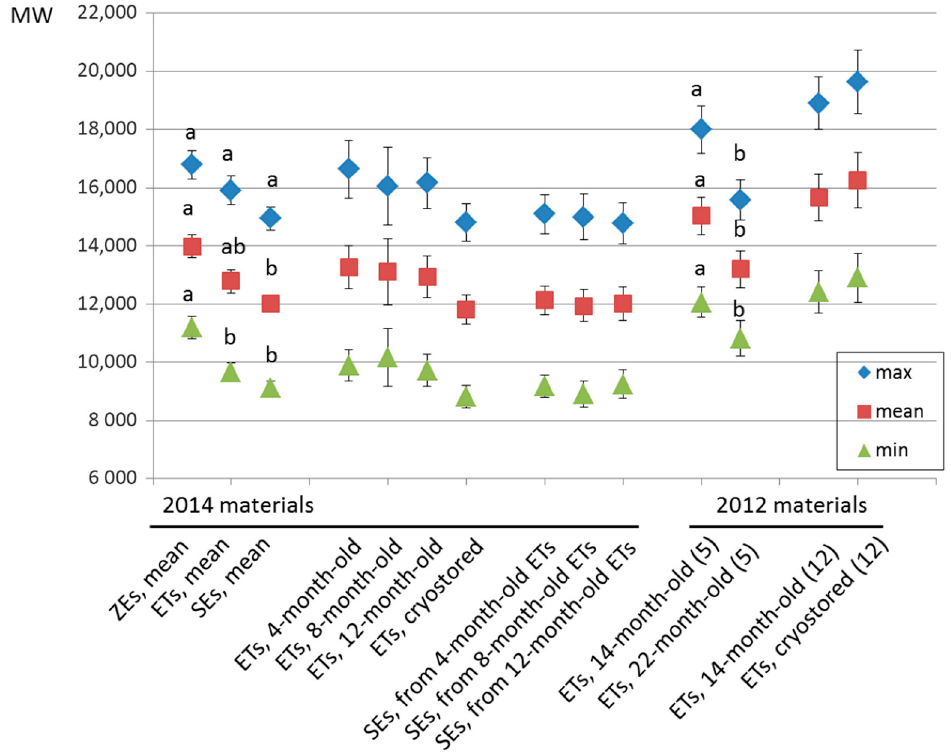
Figure 2. The length of telomeric repeats in the studied Norway spruce materials including immature zygotic embryos (ZEs), proliferating embryogenic tissues (ETs) and mature somatic embryos (SEs): The 2012 ( n = 33) and 2014 materials ( n = 85) consisting of different sets of genotypes were studied separately. In the 2012 material, significant differences between 14- and 22-month-old ETs studied with five genotypes are marked by different letters. When examining 12 genotypes of the 2012 material representing ETs continuously proliferated for 14 months or cryostored and proliferated for 14 + 1 months, no significant differences were found. In the 2014 material, no significant differences were found among ETs proliferated for 4, 8, or 12 months or cryostored when compared with each other, nor among SEs derived from different-aged ETs. The 2014 means for sample types (ZEs, ETs, and SEs) that differ significantly (Student–Newman–Keuls multiple range test, p < 0.05) from each other are marked by different letters.